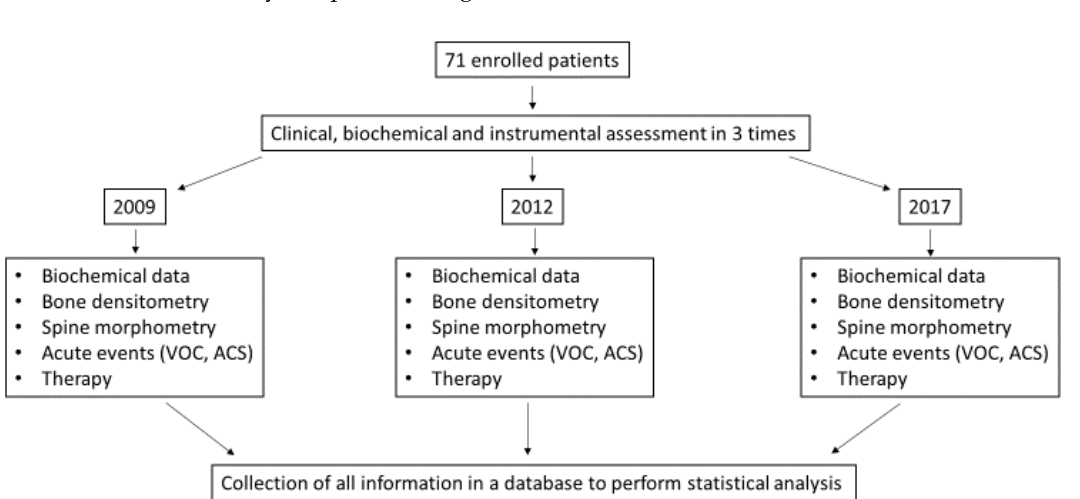
Figure 1. Flow-chart of the study. VOC: vaso-occlusive crisis; ACS: acute chest syndrome.